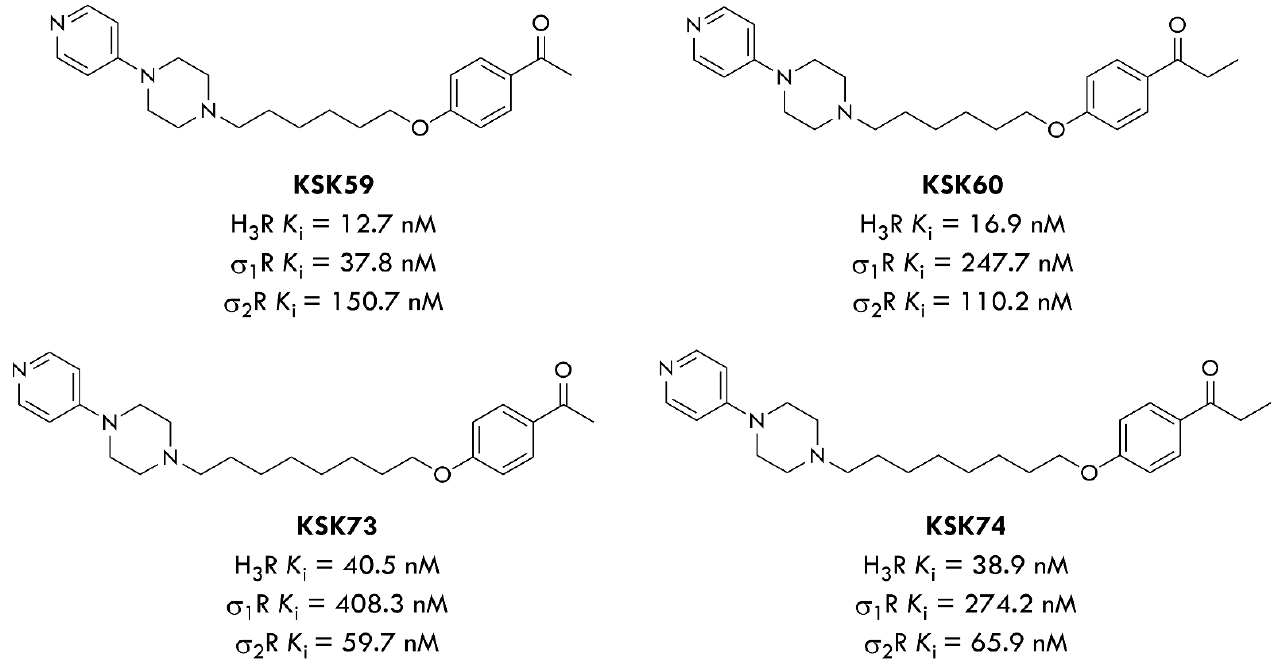
Figure 1. Structures of compounds evaluated in our previous work (KSK-59, KSK-73) and in our present work (KSK-60, KSK-74). Affinity values of the ligands tested at the H 3 R [12] and the sigma-1 and sigma-2 receptors [24]. Structure and purity confirmation data of compounds KSK-60 and KSK-74 were shown in Supplement S1.